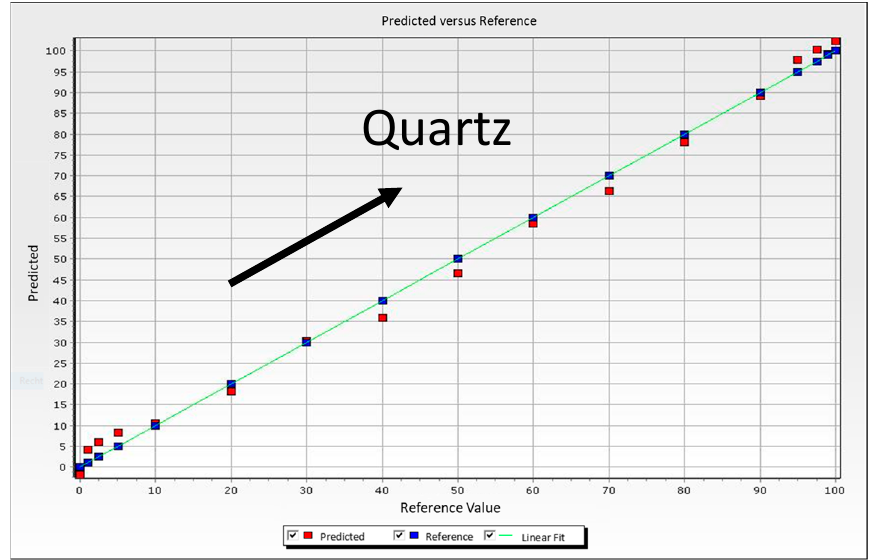
Figure 21. Calibration curve for lepidolite–quartz mixtures.